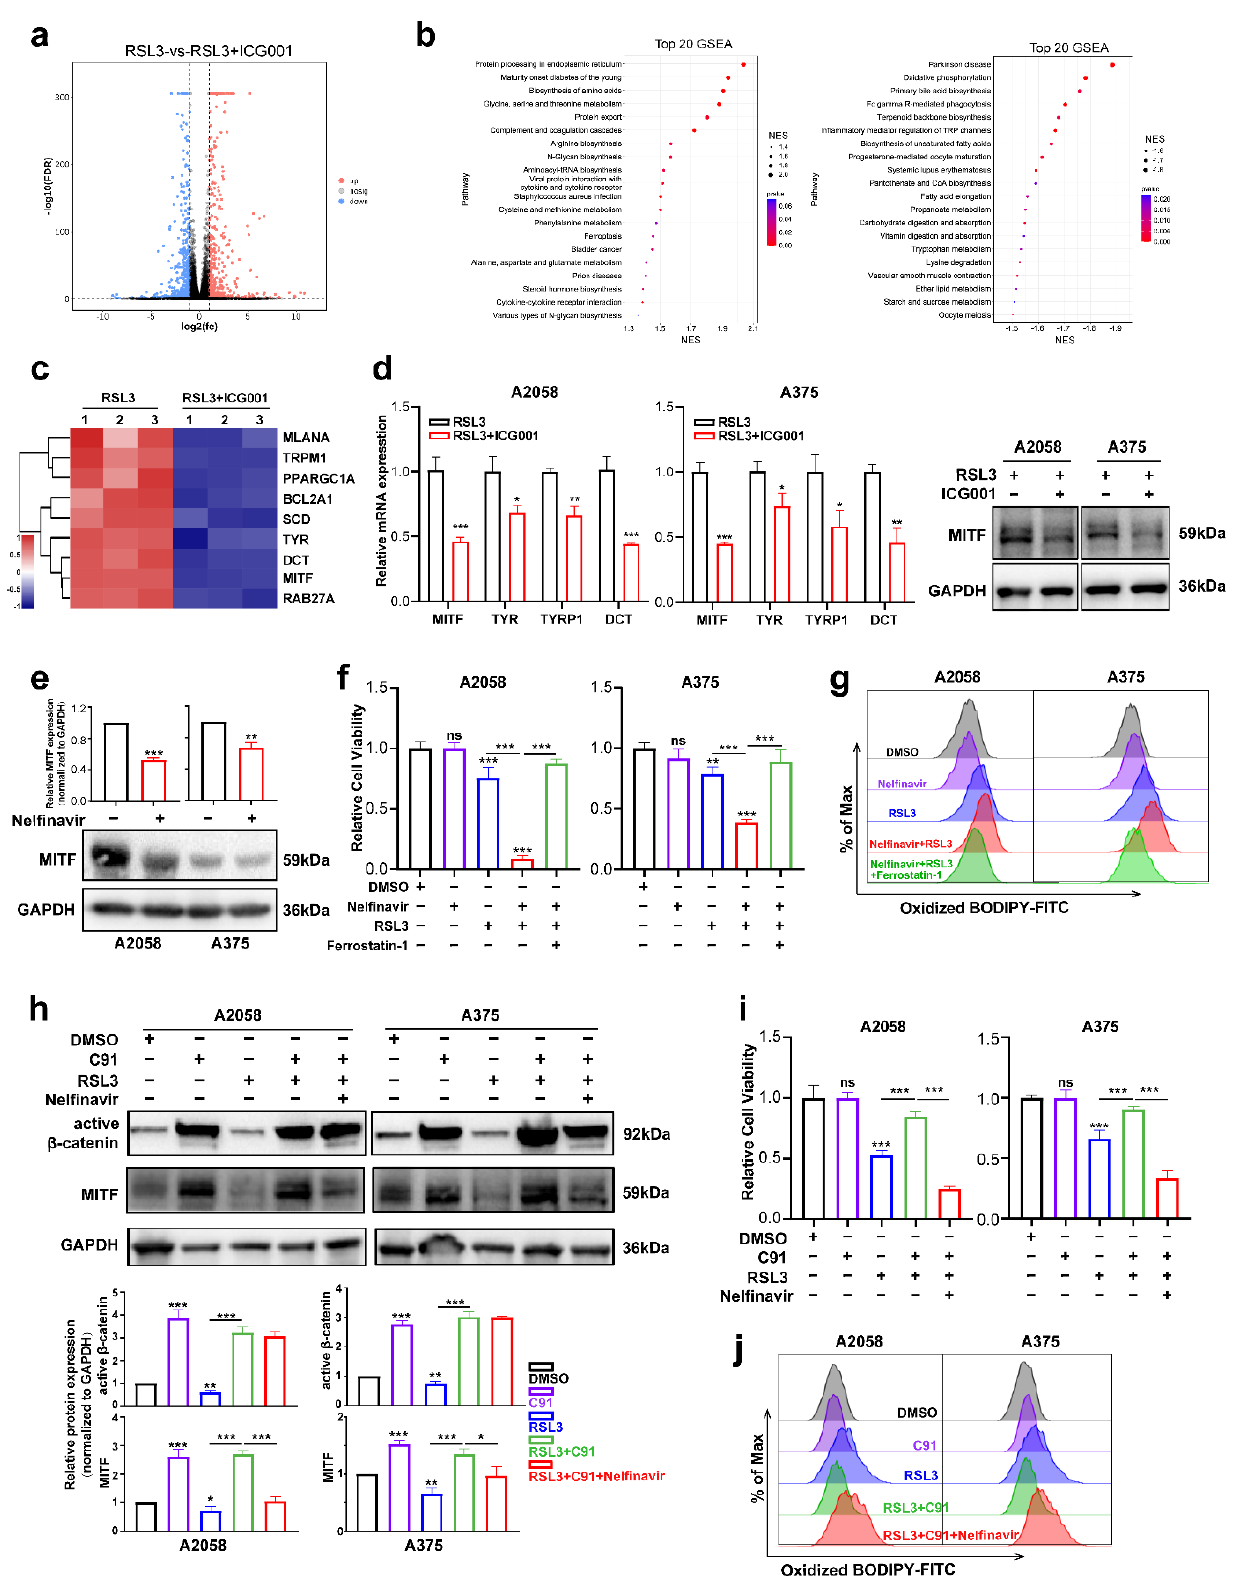
Figure 4. MITF mediates the influence of Wnt/β -catenin signaling on melanoma cell ferroptosis. ( a ) Volcano map displaying the differentially expressed genes between the RSL3 monotreatment group and the RSL3+ICG001 combined treatment group in the A2058 melanoma cell line. ( b ) The GSEA analysis displays the pathways enriched by differentially expressed molecules between the RSL3 monotreatment group and the RSL3+ICG001 combined treatment group. NES (normalized enrich- ment score). ( c ) Heatmap displaying that MITF and its downstream targets are differentially ex- pressed between the RSL3 monotreatment group and RSL3+ICG001 combined treatment group. ( d ) Relative mRNA levels of MITF, TYR, TYRP1 and DCT, as well as protein levels of MITF, in the